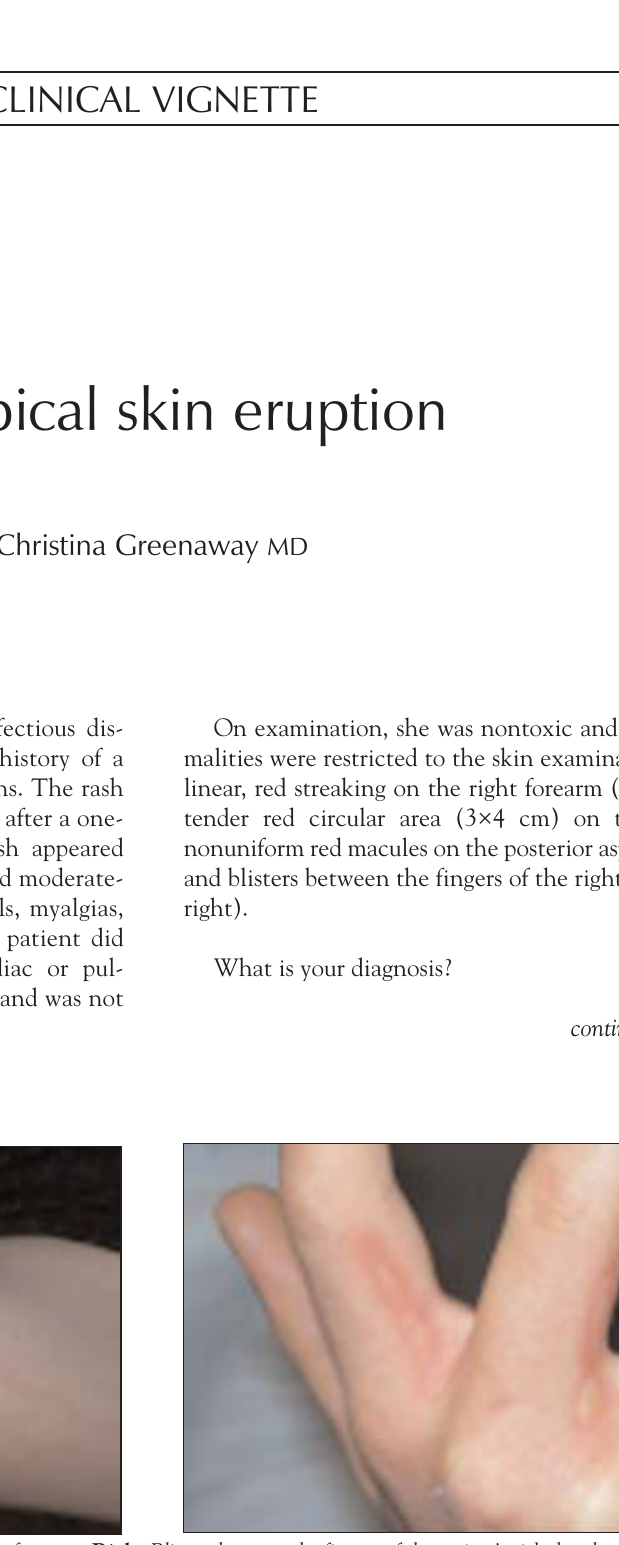
Figure 1) Left Linear red streaking on the patient’s right forearm. Right Blisters between the fingers of the patient’s right